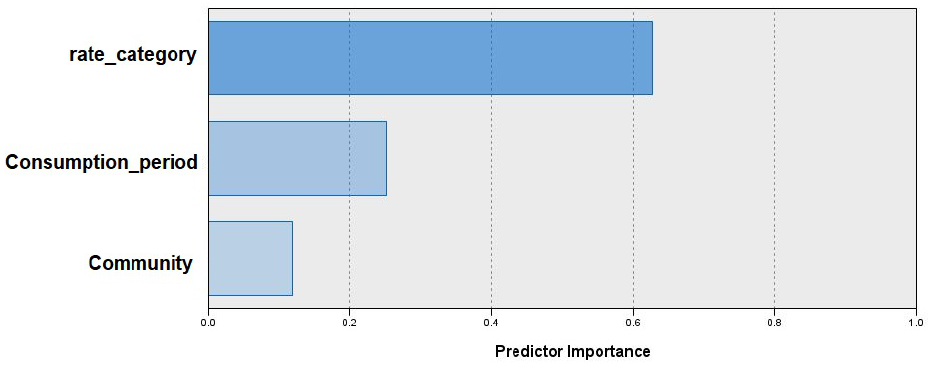
Figure 7. Feature selection using